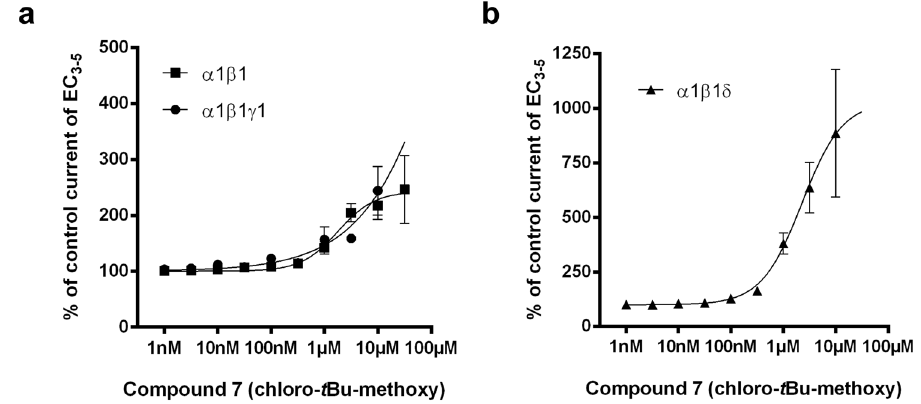
Figure 6. Compound 7 modulates GABA-evoked currents in α 1 β 1, α 1 β 1 γ 1 and α 1 β 1 δ receptors. ( a,b ) Concentration-dependent modulation of GABA EC 3–5 current at α 1 β 1, α 1 β 1 γ 1 and α 1 β 1 δ receptors. Data represent means ± SEM (n = 4–17) (see Supplementary Table